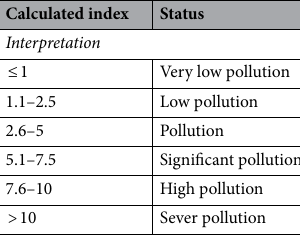
Table 1. CBPI status categories 23